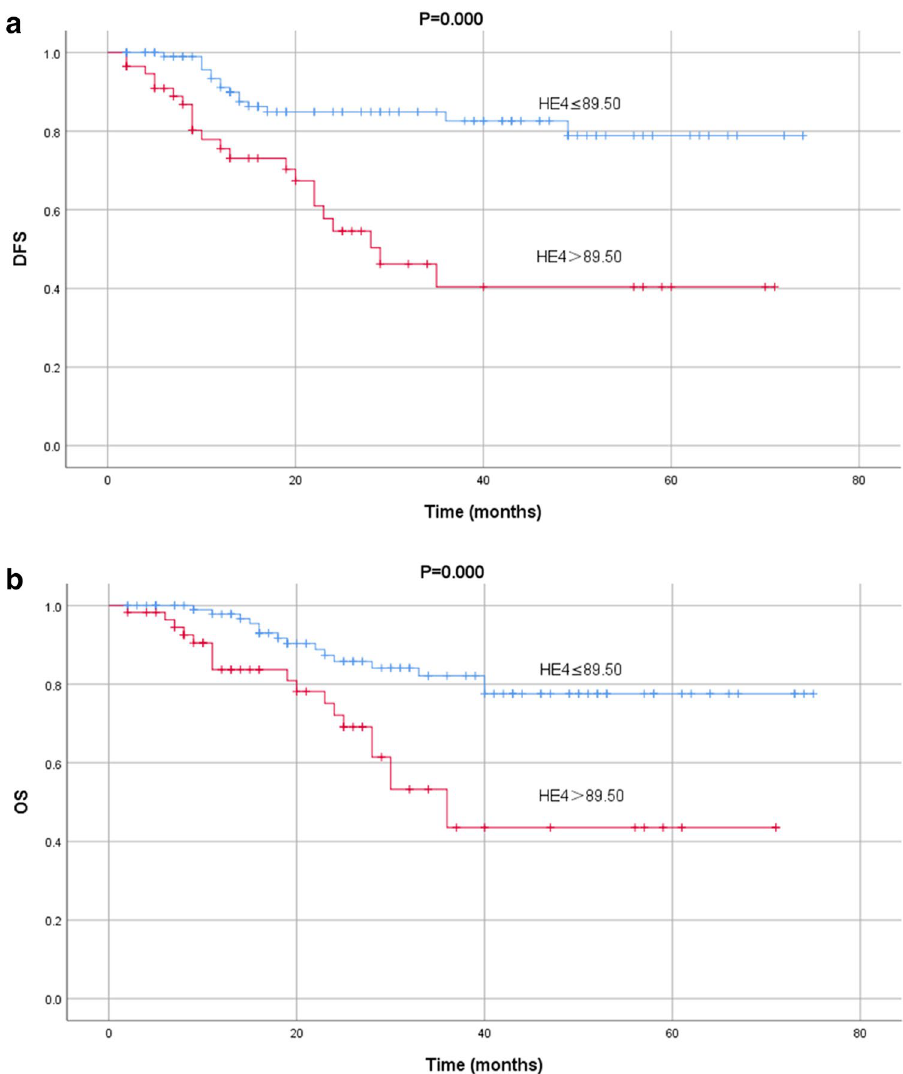
Figure 2. Kaplan–Meier curves for the disease-free survival ( a ) and overall survival ( b ), according to HE4 at primary diagnosis. Cut-off values were 89.50